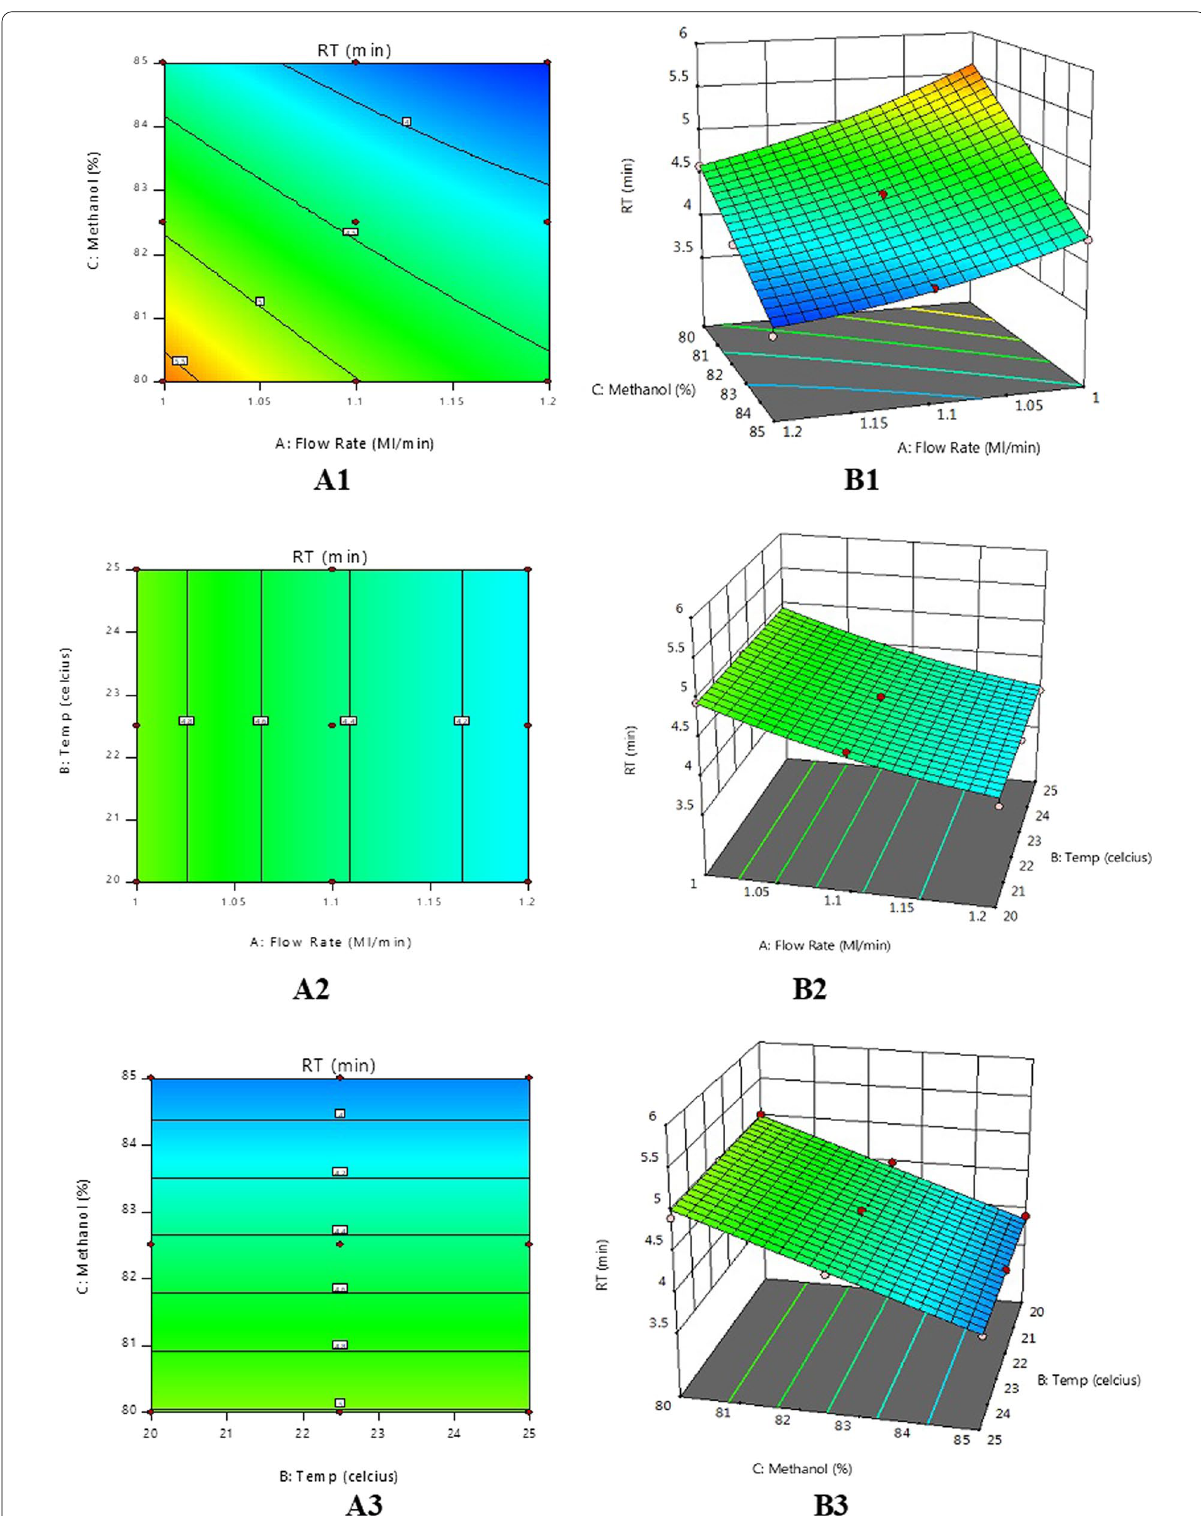
Fig. 3 Relation plots (A1-A3; B1-B3) between true and measure values for